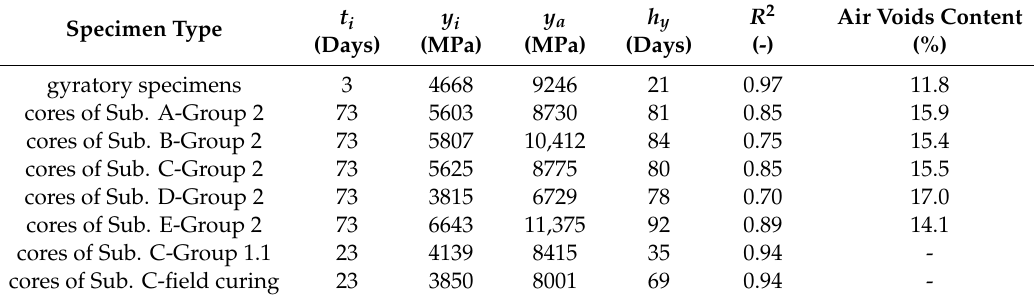
Table 10. Estimated values of the regression parameters and air voids content of specimens of Group 0, Group 1.1, Group 2 and field